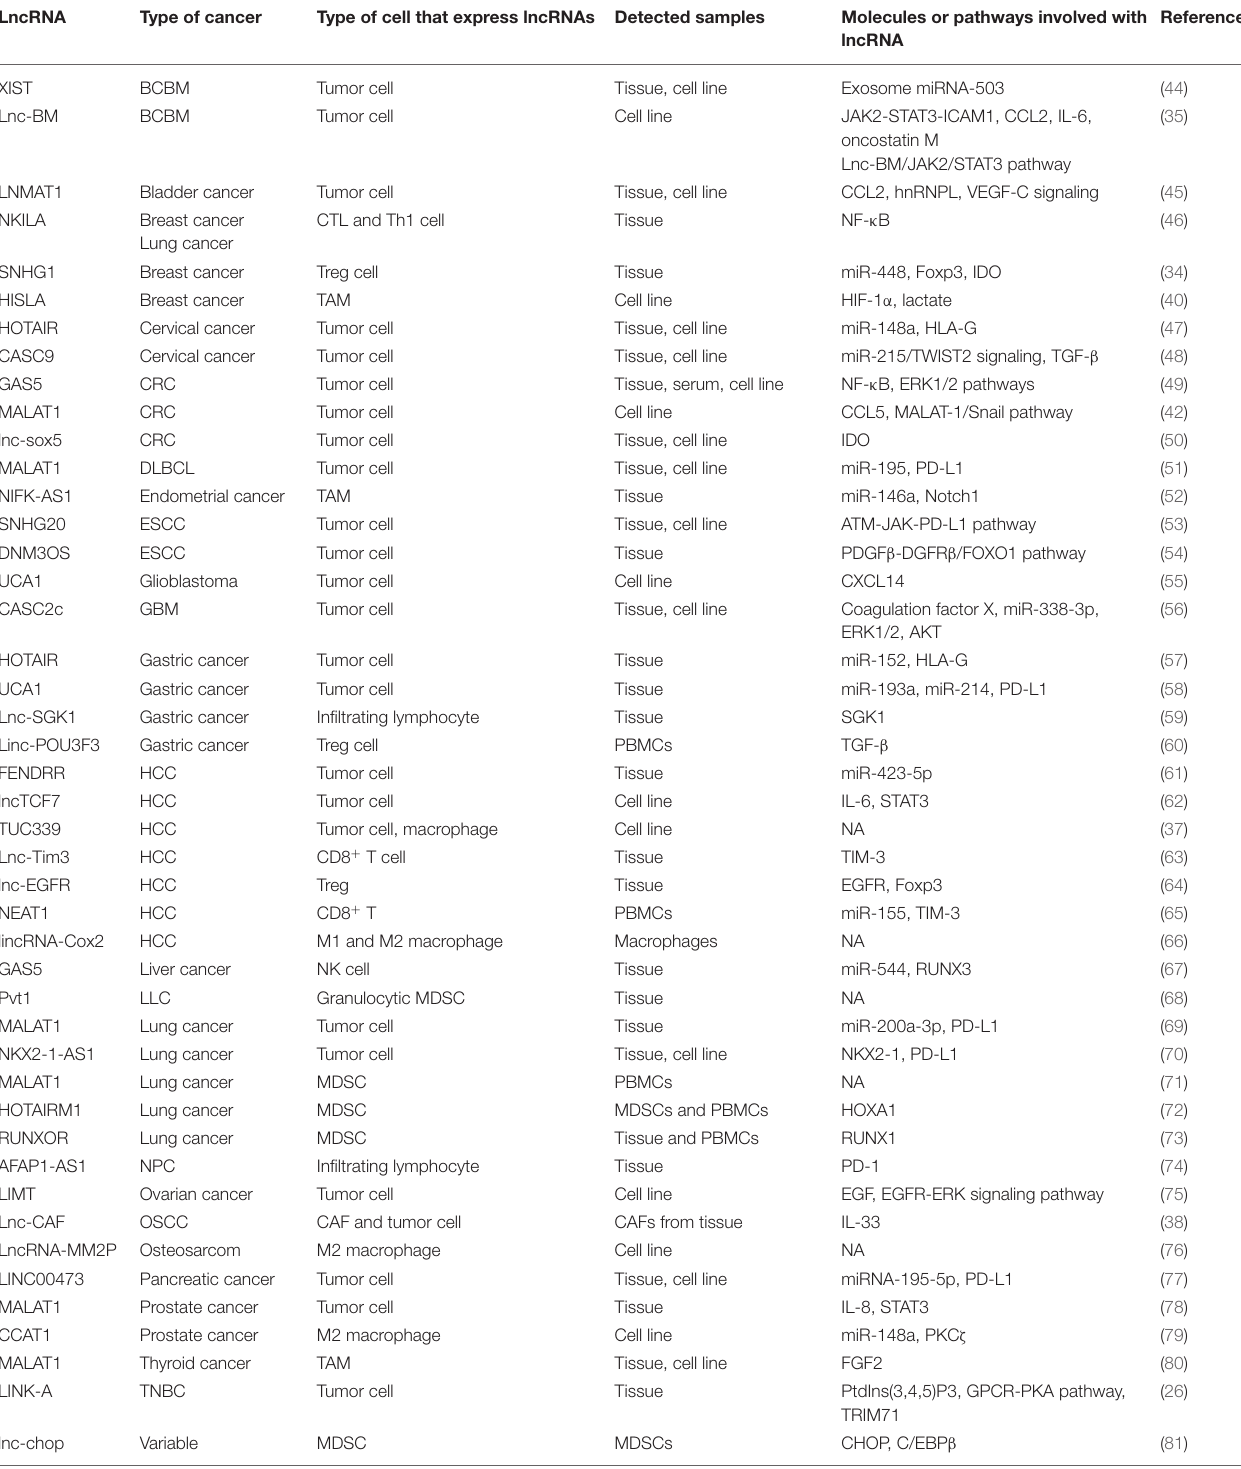
TABLE 1 | Long non-coding RNAs (lncRNAs) and their respective molecules or pathways involved in the tumor microenvironment (TME) immunosuppression.